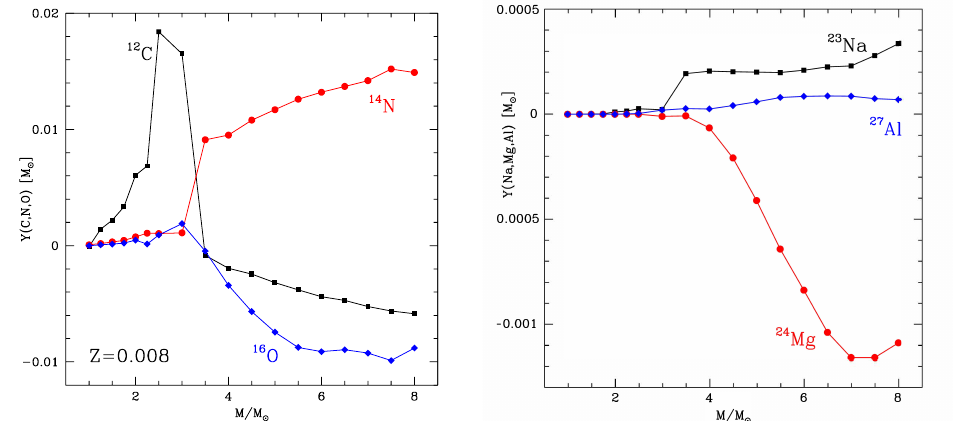
Figure 4. Yields of the most abundant isotopes involved in the CNO nucleosynthesis ( left panel) and of sodium, magnesium, and aluminium ( right ) of Z = 8 × 10 − 3 stars of different initial